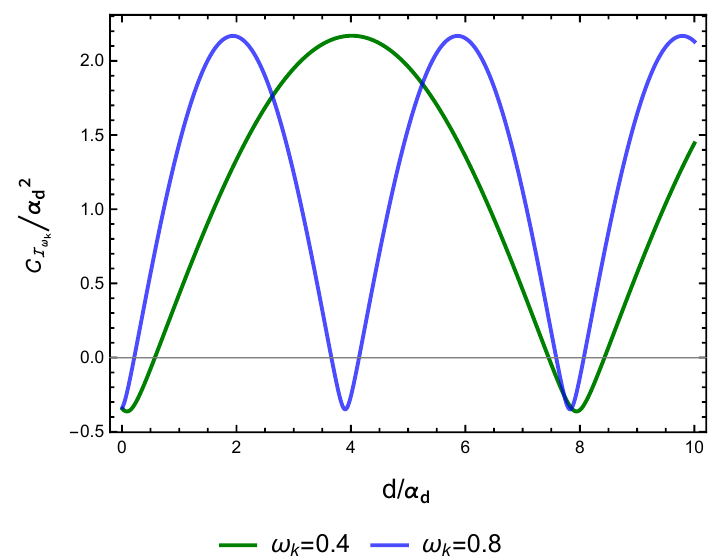
is plotted for two outgoing null detectors in different parallel Figure 19 . The quantity C I /α 2 d ωk paths in a (1 + 1) dimensional de-Sitter spacetime with respect to the separation between the two paths d/α for different dimensionless frequencies of the field. The detector transition energies are d fixed at ∆ E = 0 . 5